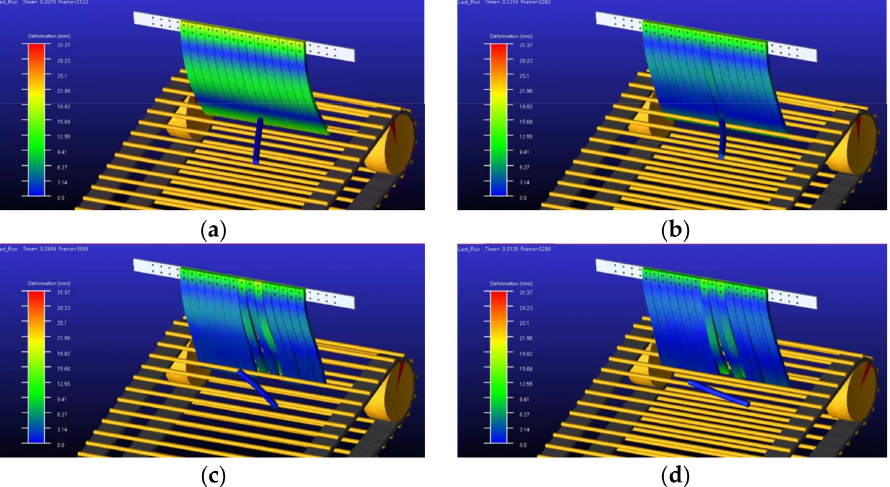
Figure 9. Simulation of potato stem transported-posture adjustment process. ( a ) Stem transported by separating sieve. ( b ) Stem colliding with elastic curtains. ( c ) Stem rebounding and separating from the elastic curtains. ( d ) Stem colliding with separating sieve rod.